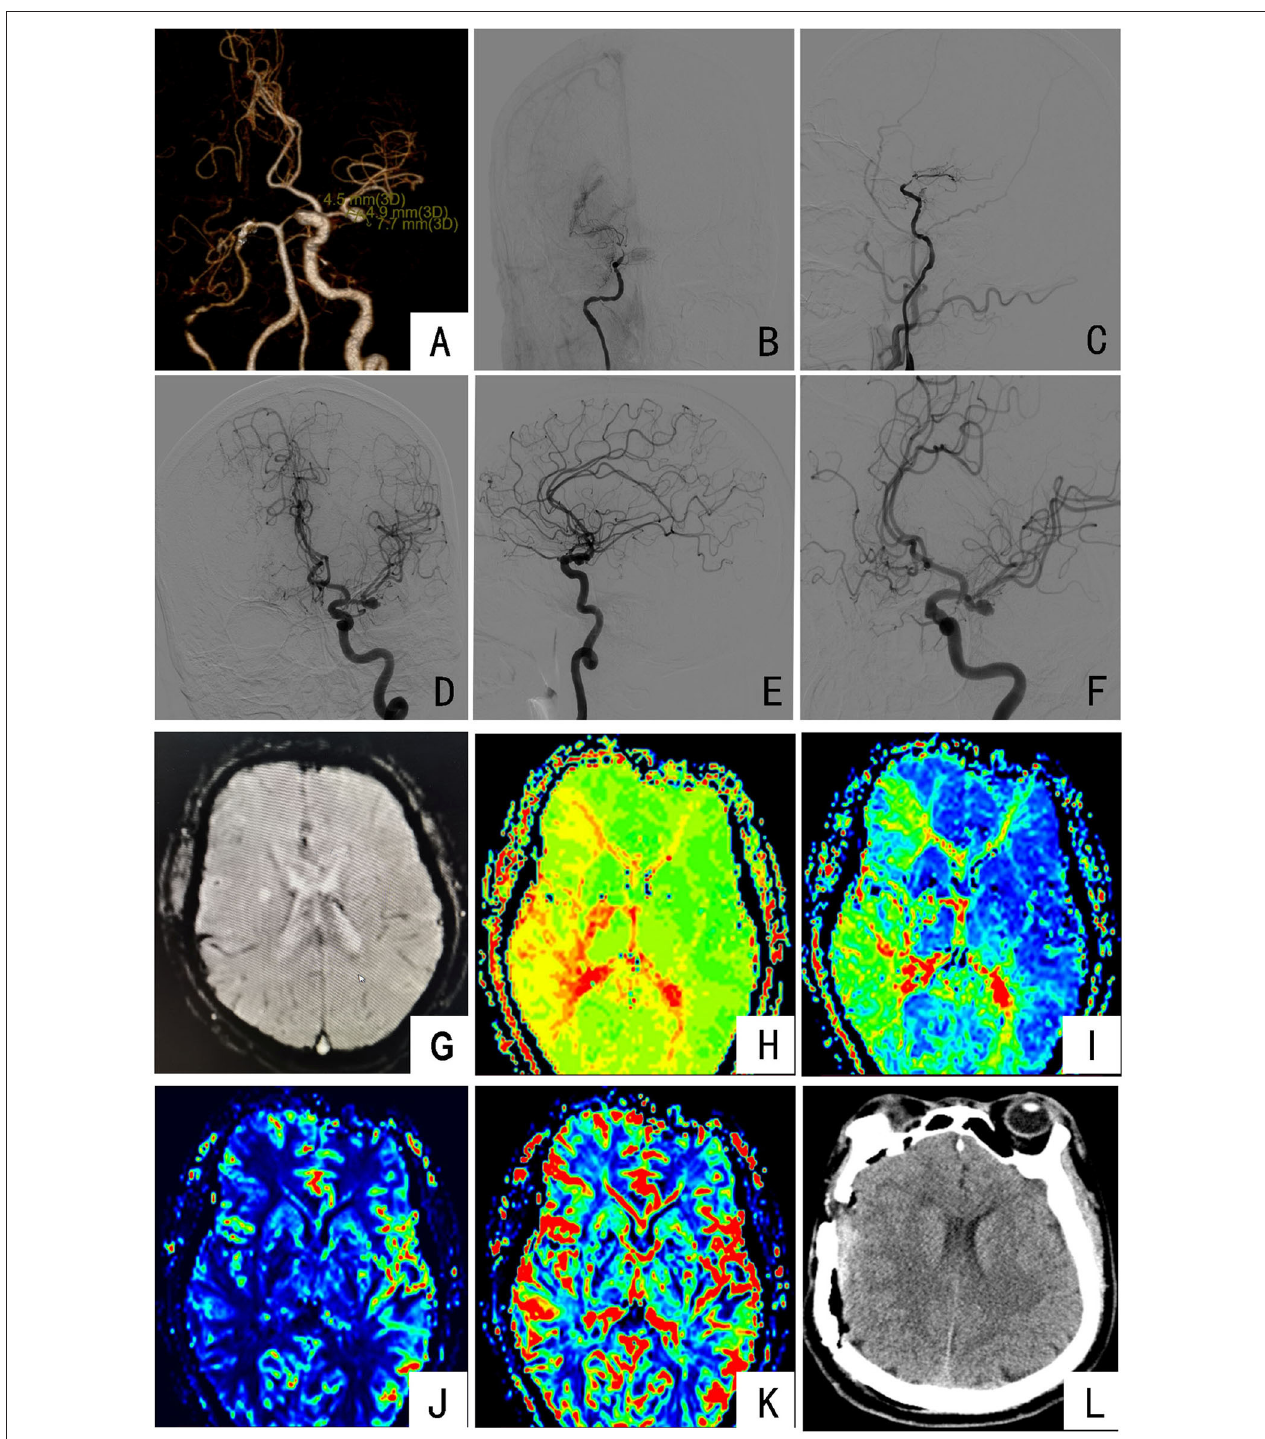
FIGURE 2 | Preoperative and postoperative imaging examinations of the patient: (A) CTA showing occlusion of the right middle cerebral artery with the formation of small collateral vessels and the M1 segment of the left middle cerebral artery aneurysm; (B,C) DSA imaging showing that the cavernous sinus of the right internal carotid artery was occluded at the distal end, and the surrounding smoke-like blood vessels were formed; (D–F) DSA imaging showing that the end of the left middle cerebral artery M1 was an irregular aneurysm; (G) MRI indicates the right basal ganglia and corona demalaciasis; (H,I) PWI indicates bilateral oval center, radiated coronal area, temporoparietal occipital lobe, right frontal lobe and basal ganglia, and cerebellar hemisphere TTP and MTT prolongation; (J,K) PWI indicates a decrease in local CBF and no significant change in CBV; (L) the results of head CT on the first day after surgery.